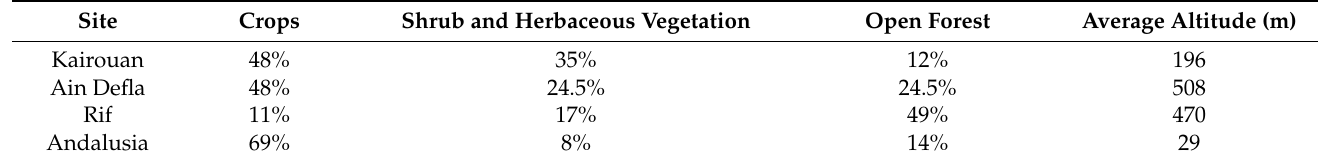
Table 1. Percentages of crops, shrubs, herbaceous vegetation, and open forests and average altitude at the four studied sites. Site Crops Shrub and Herbaceous